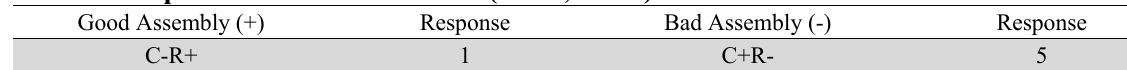
Table 7: Response for Hook Base Plate (C-R+, C+R-)